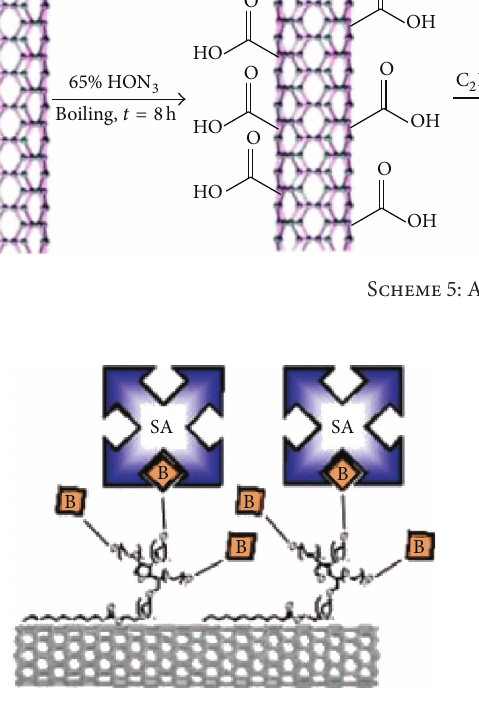
Figure 6: Streptavidin recognition by a nanotube coated with biot- inylated Tween (adapted from [33]).